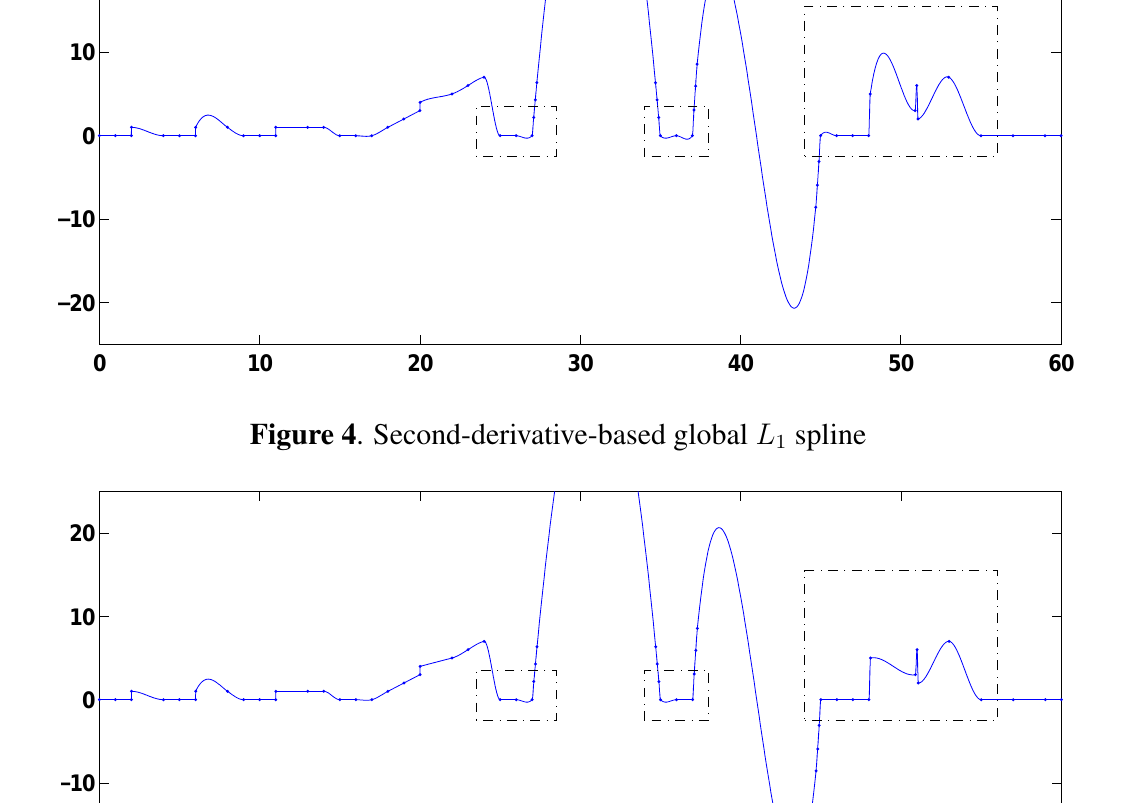
Figure 3 . Second-derivative-based 7-point-window L